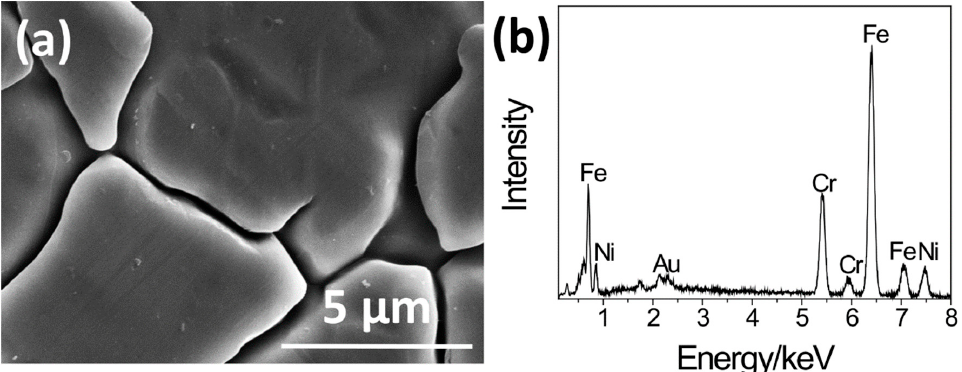
Figure 2. ( a ) SEM picture and ( b ) EDS spectrum of the surface of S0.